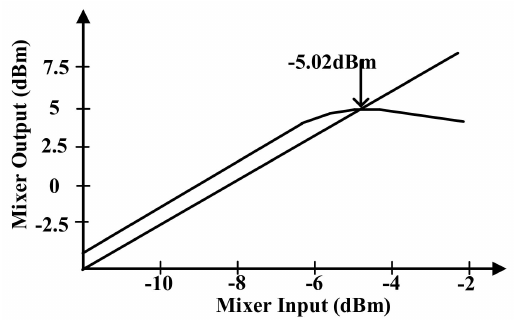
Figure 17. P1dB simulation of the receiver mixer.